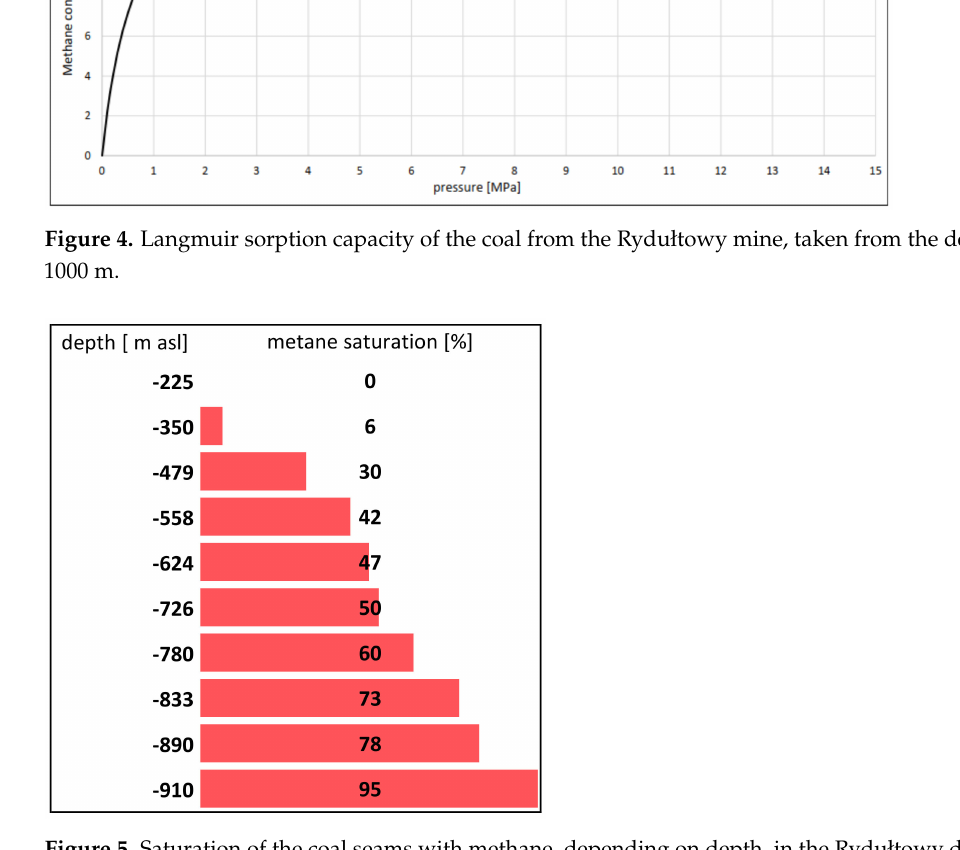
Figure 5. Saturation of the coal seams with methane, depending on depth, in the Rydułtowy